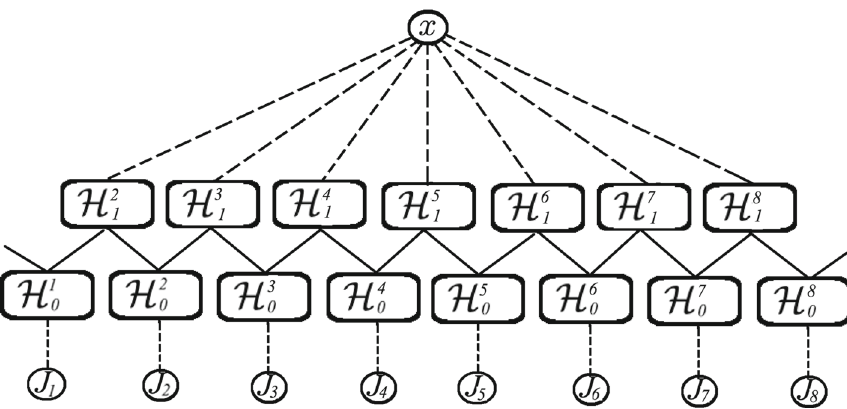
Fig. 4 Interactions network for Ising